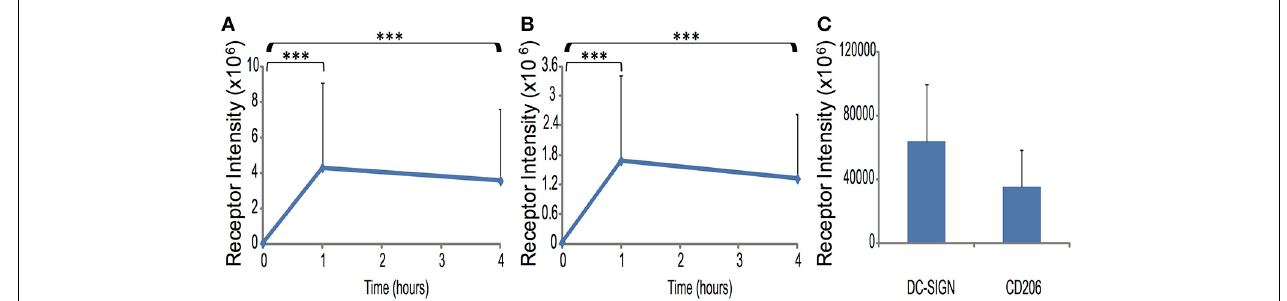
FIGURE 1 | Total receptor enrichment in fungal contact sites. Spatiotemporal distribution of total DC-SIGN (A) and CD206 (B) signal intensity at the contact site during interaction between human immature dendritic cells and zymosan particles. (C) A graph showing the DC-SIGN and CD206 receptor intensity at time = 0h. Receptor signal was measured by